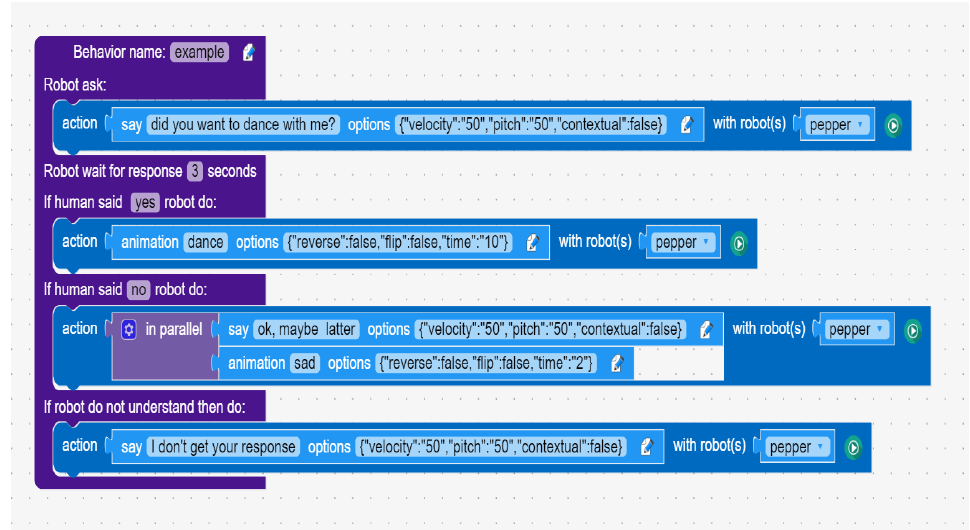
Figure 4. Example of a programming blocks in the Robot Interface from Zero Experience (RIZE) enabling interaction with